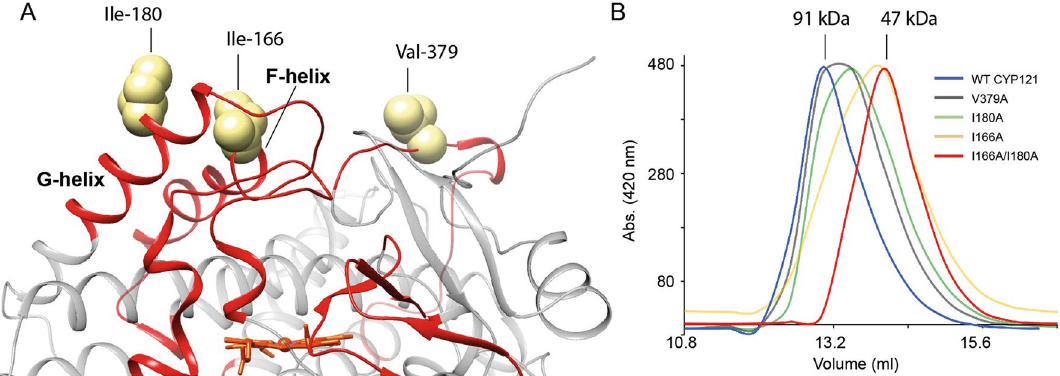
Figure 1. Engineering a monomer of CYP121A1. ( A ) Distribution of non-polar, solvent-exposed side chains on the distal surface of the protein. ( B ) Gel filtration column elution of WT and alanine mutations of CYP121A1. The figure in ( A ) was generated using UCSF Chimera v1.14 (www.cgl.ucsf.edu/chime